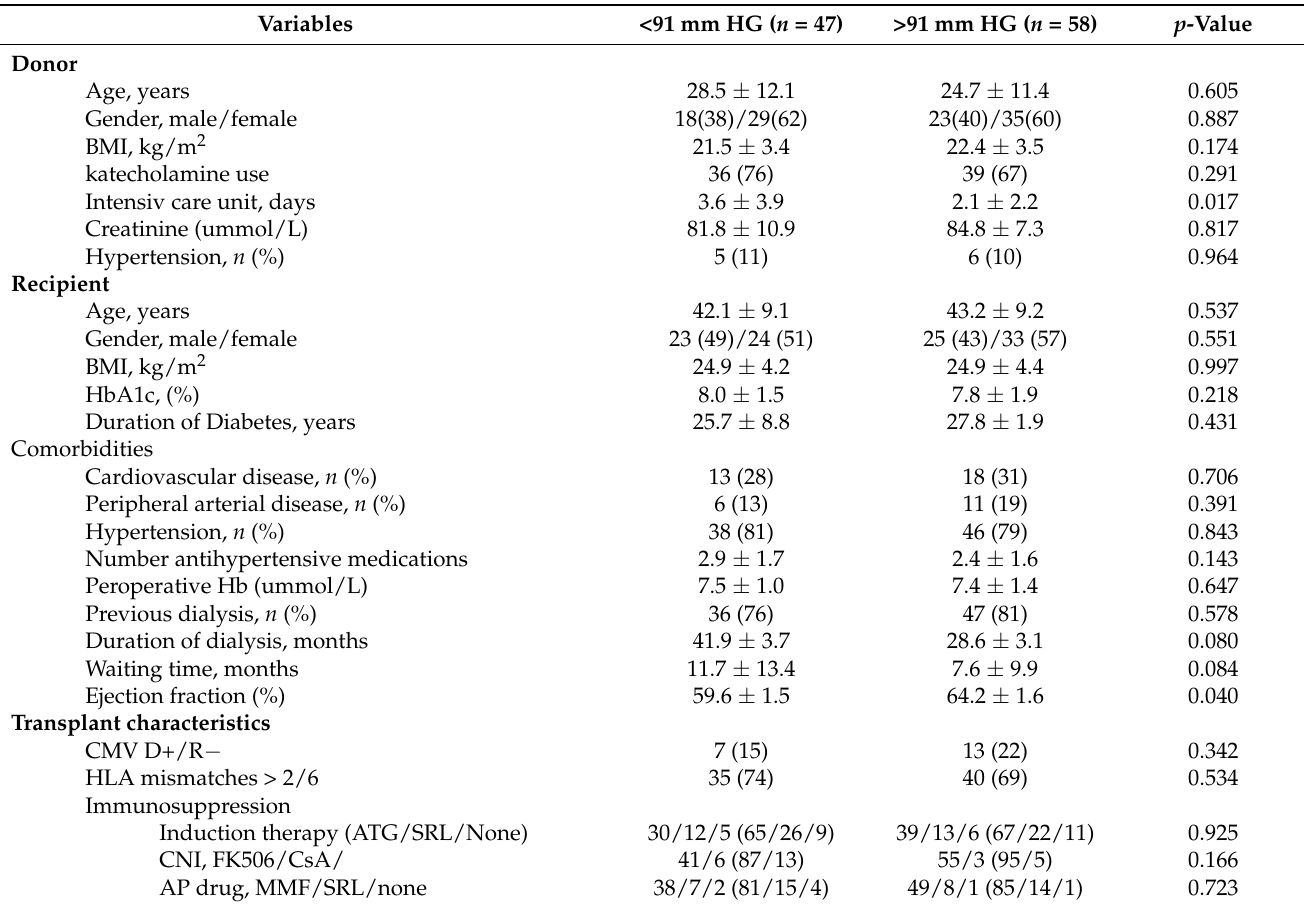
Table 1. Baseline perioperative transplant characteristics of recipient and